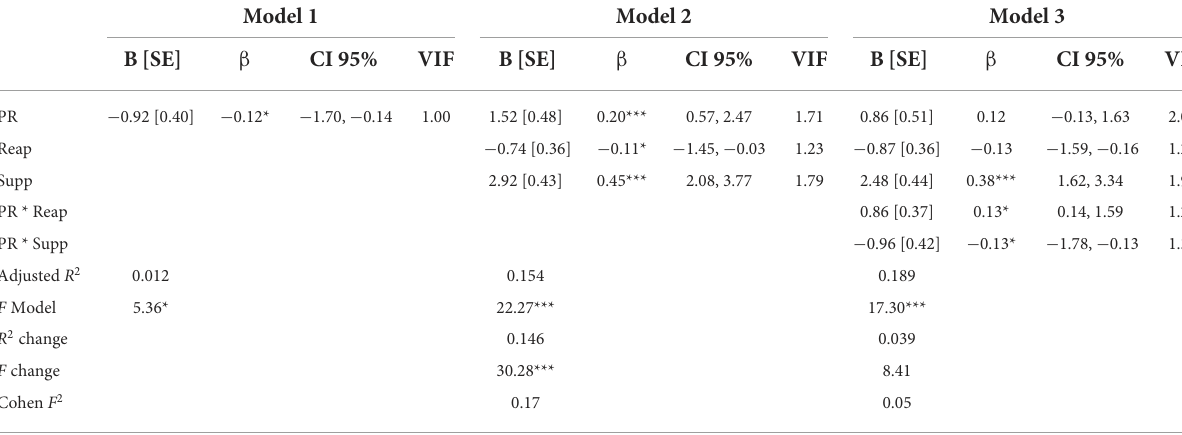
TABLE 4 Moderation model for the association between positive rumination and insomnia symptoms.